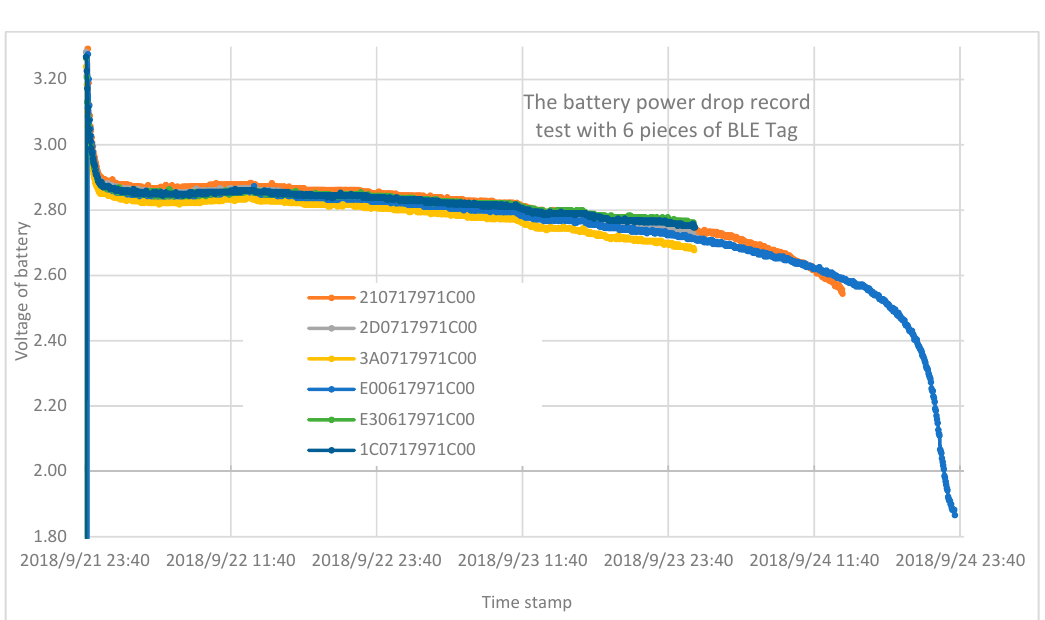
Figure 24. Six BLE Tags working time experiment recorded using six CR2032 batteries.